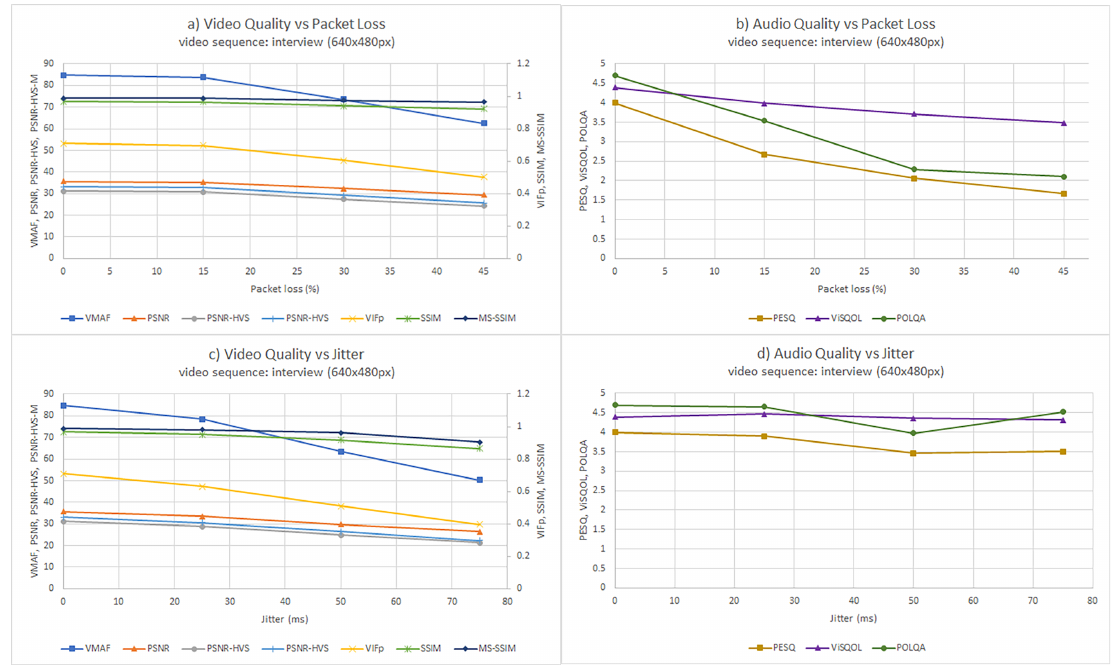
Figure 4. Objective results for the interview sequence: ( a ) Video quality results using different scenarios of packet loss. ( b ) Audio quality results using different scenarios of packet loss. ( c ) Video quality results using different scenarios of jitter. ( d ) Audio quality results using different scenarios of